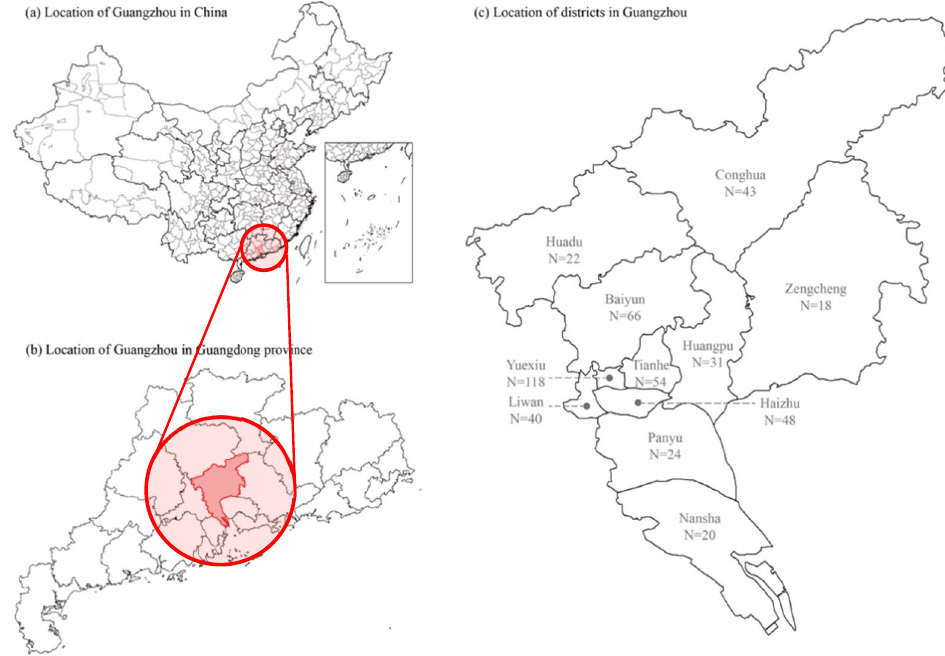
Figure 2. The location and internal distribution of the projects. N = the number of community regeneration projects in the first phase of the plan (Source: Compiled by the researcher).